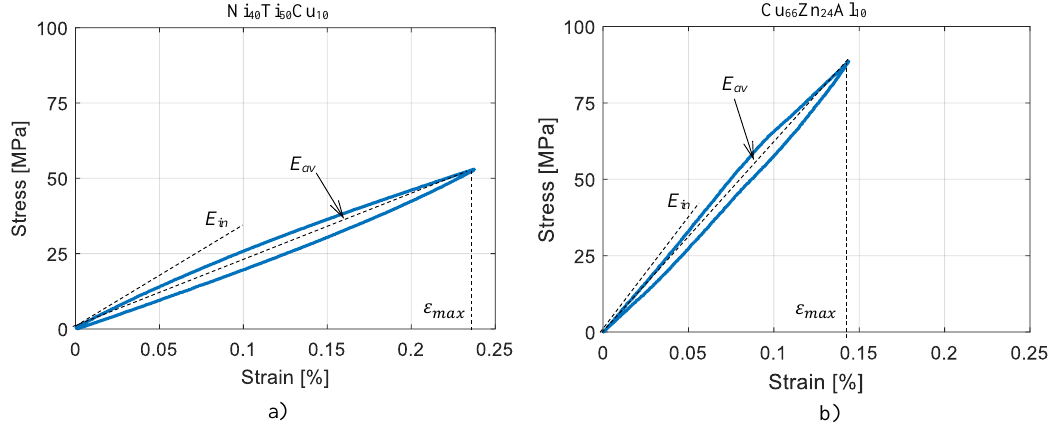
Figure 6. Hysteresis cycles of reference: ( a ) Ni 40 Ti 50 Cu 10 , ( b ) Cu 66 Zn 24 Al 10 . Table 2. Parameters of the modified Masing